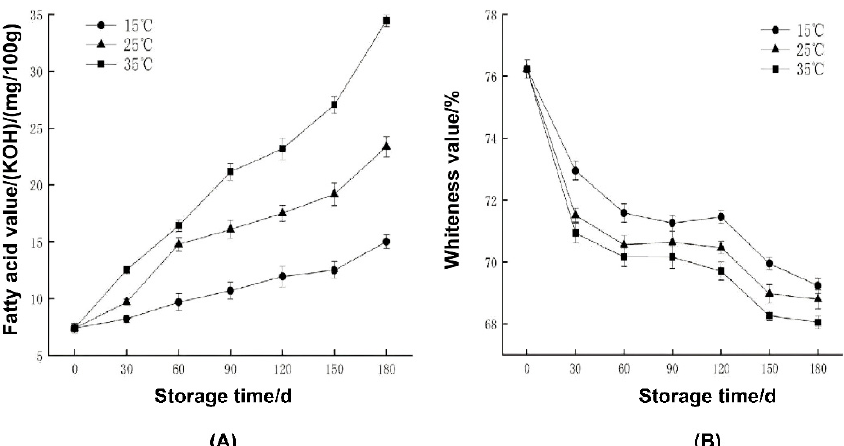
Figure 1. Changes in fatty acid value ( A ) and whiteness value ( B ) at different storage temperatures.